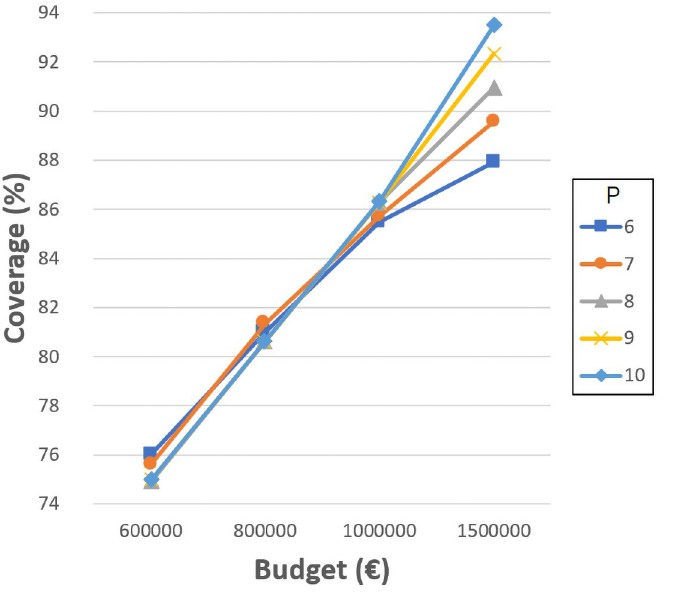
Fig 12. Coverage in 2010-2015 with new schools.